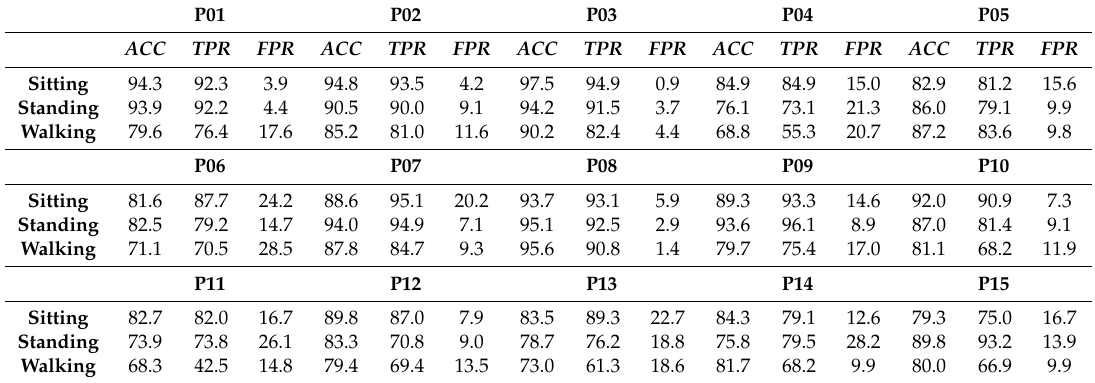
Table 3. Performance results of our algorithm in detecting talking for each participant